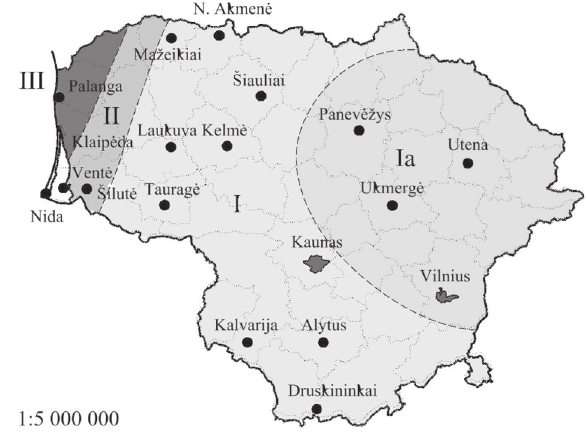
Fig. 6. The map of characteristic wind pressures w 0 specified in the design code SNiP 2.01.07-85 (see also Table